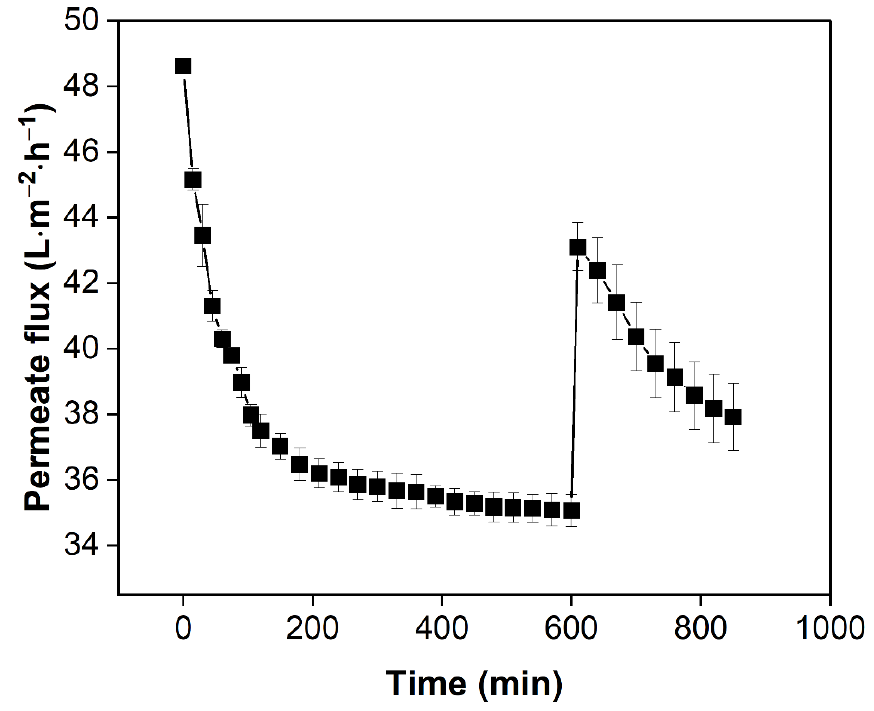
Figure 9. Permeate flux variation during the membrane running process. Before ultrasonic cleaning, membranes had been running for 10 h. After 10 min of ultrasonic cleaning, the membrane was kept running for another 4 h. Membrane operating conditions: feed solution, actual desulfurization wastewater diluted 10 times; feed flow rate, 35 L·h −1 ; operating pressure, 0.5 MPa; temperature, 18 Table 1. Permeate concentration and rejection variation before and after ultrasonic cleaning.